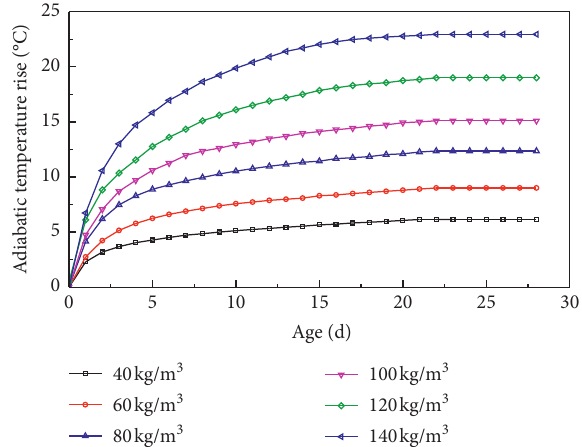
Figure 4: Adiabatic temperature rise curve of different cementing agent